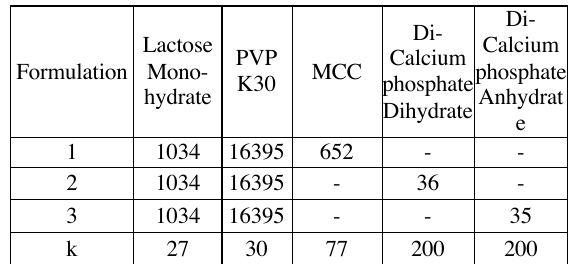
Table 3. Calculated bond number for